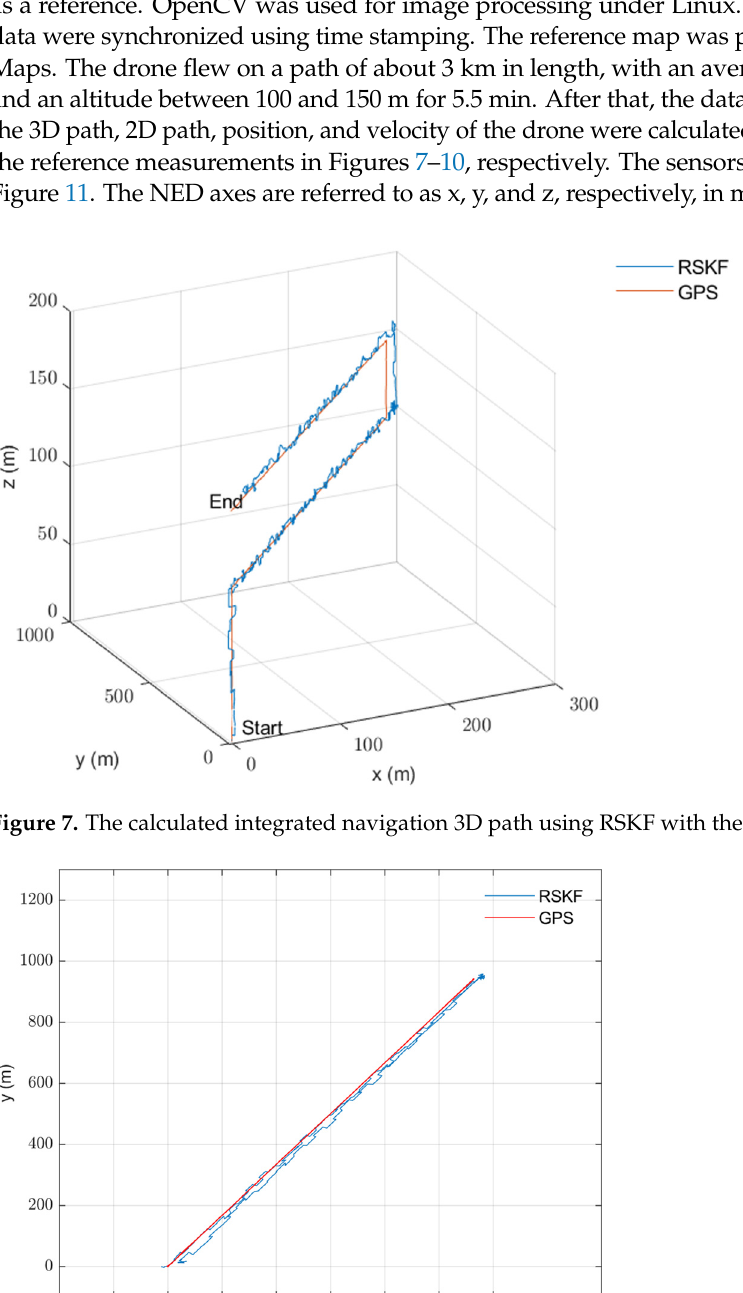
Figure 8. The calculated integrated navigation horizontal path using RSKF with the reference hori- zontal path. The closed path in the horizontal plane is a good indicator of the INS drift compensa- tion.